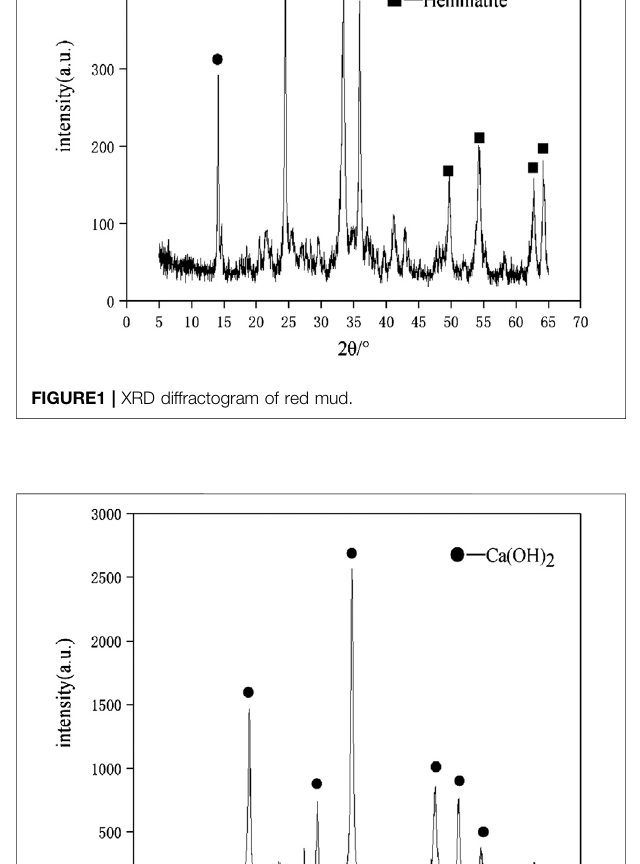
Figure 4 . Table 2 listed other physical properties of red mud and fl y ash. Natural river sand had a particle size ranged from 0.16 to 2.36 mm, which granules were well formulated, and the apparent density was 2,750 kg/m 3 , the fi neness modulus was 2.87 and the mud content was 1.3%.